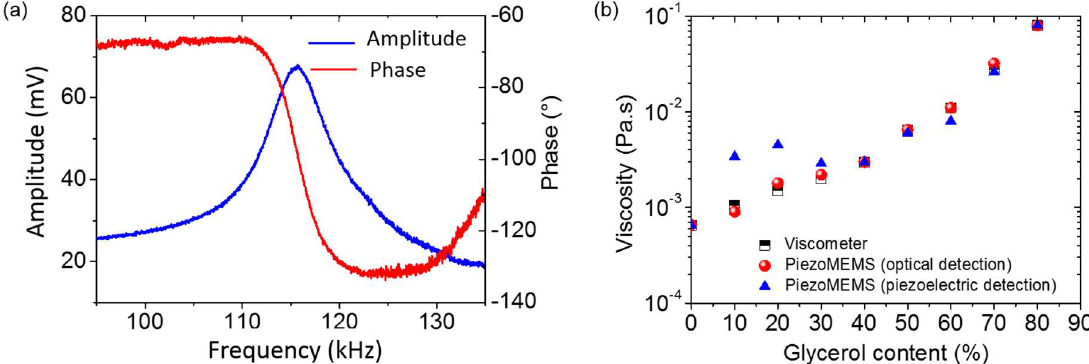
Figure 3. ( a ) Amplitude and phase of the roof-tile-shaped mode resonant frequency; ( b ) Comparison of viscosity values obtained with a commercial viscometer (mass density has to be known for such measurements) and the piezoelectric MEMS using optical and piezoelectric detections (no information on the fluid properties is necessary).